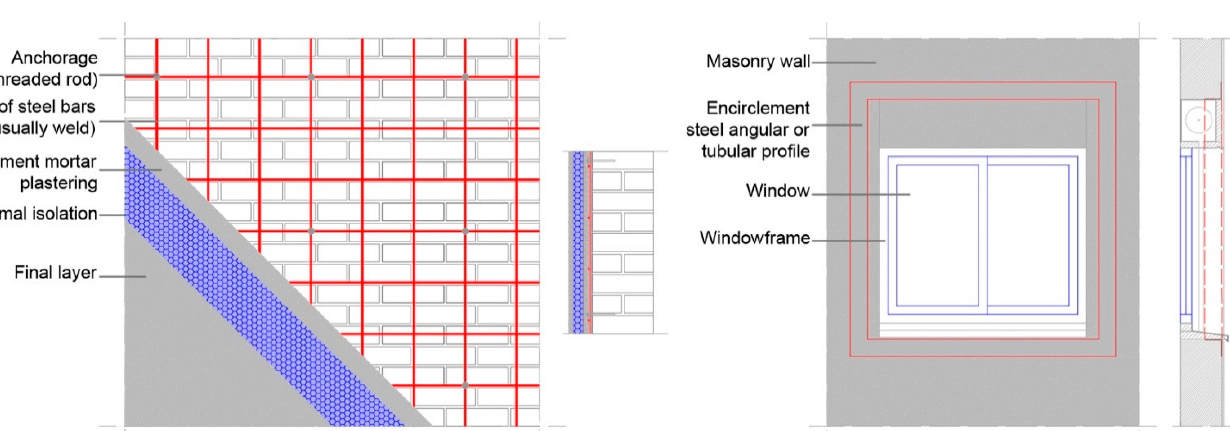
Figure 9. Dwelling annual thermal demand for the as-built hypothesis, including the surface of each dwelling.